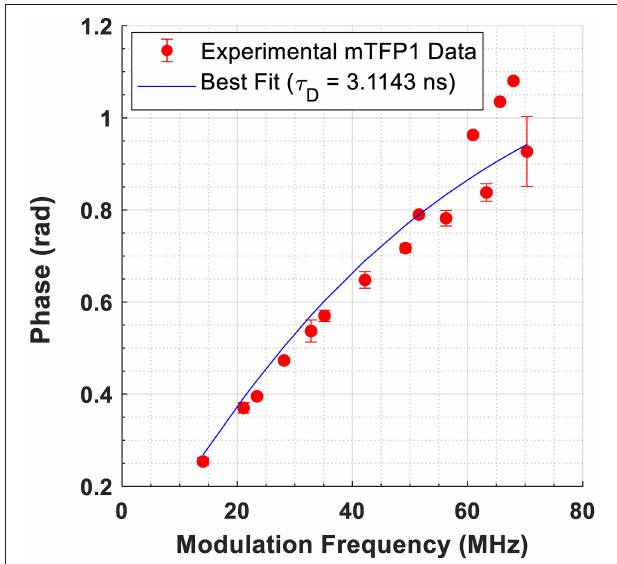
τ D ) to data from cells expressing mTFP1 at tan − 1 ( 2 π f · = 3.1143 0.017 ns ( χ 2 0.0699). = ± =